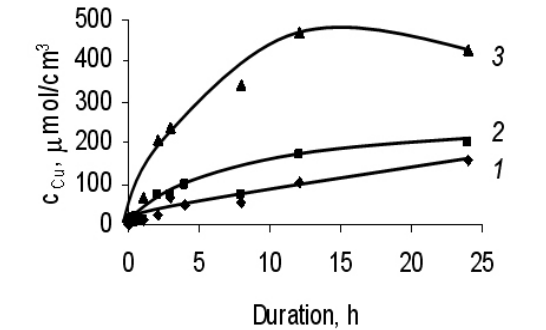
in K TeS O solution at a temperature of 10 o C. Concentration 2 4 6 of K TeS O , mol dm -3 : 1 – 0.025, 2 – 0.05, 3 –0.1 2 4 6